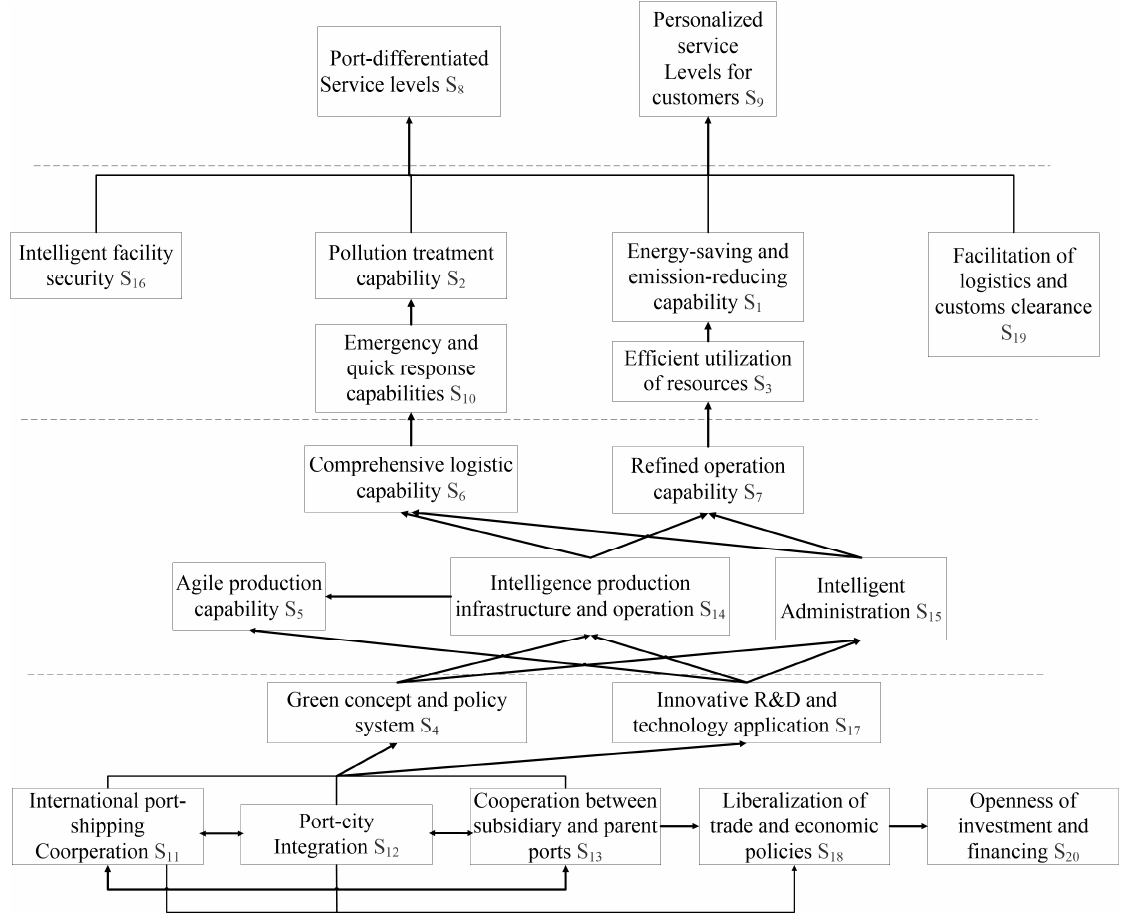
Figure 3. Governance framework of critical influencing factors for green and smart ports.